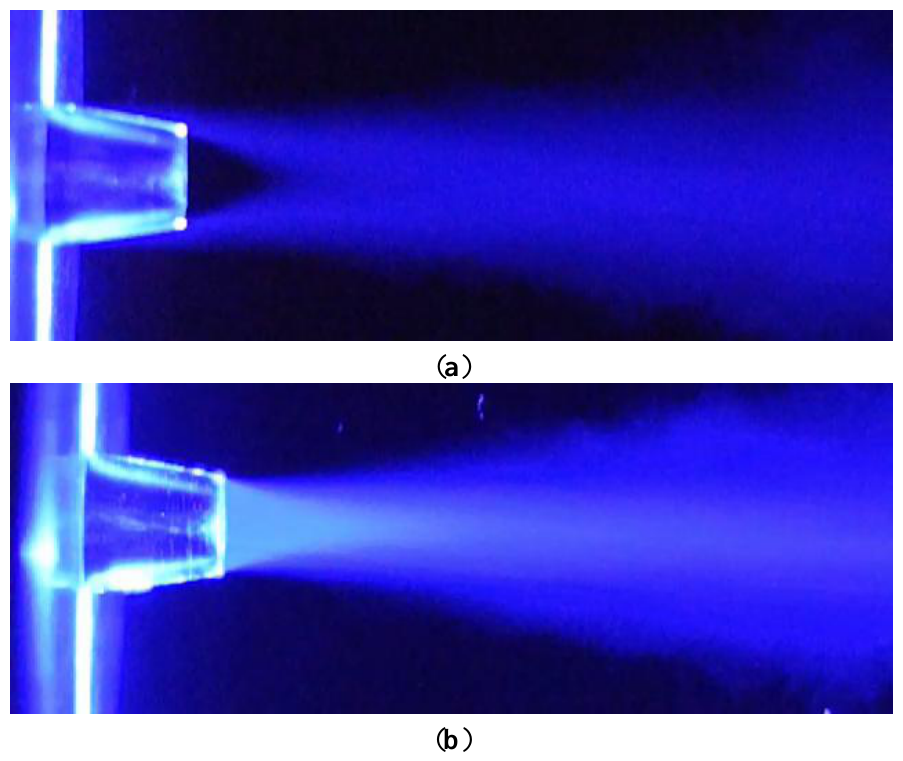
Figure 9. Experiment 2 flow visualization of nozzle near field flow seeded by micron-sized glycerine-water droplets: ( a ) seeding the annular air line; ( b ) seeding the powder air